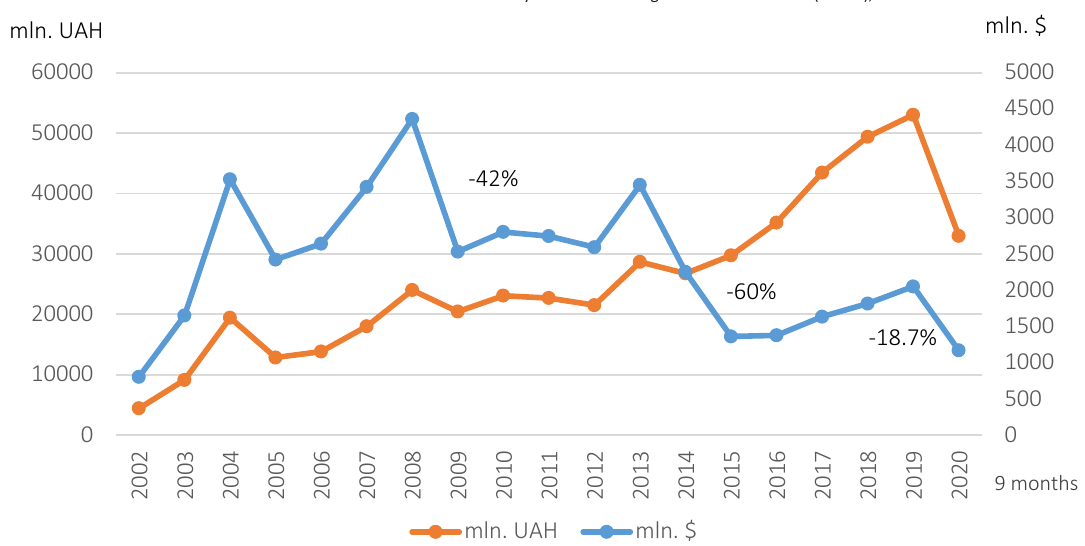
Figure 1. Dynamics of gross insurance premiums in Ukraine over the period of 2002–2020